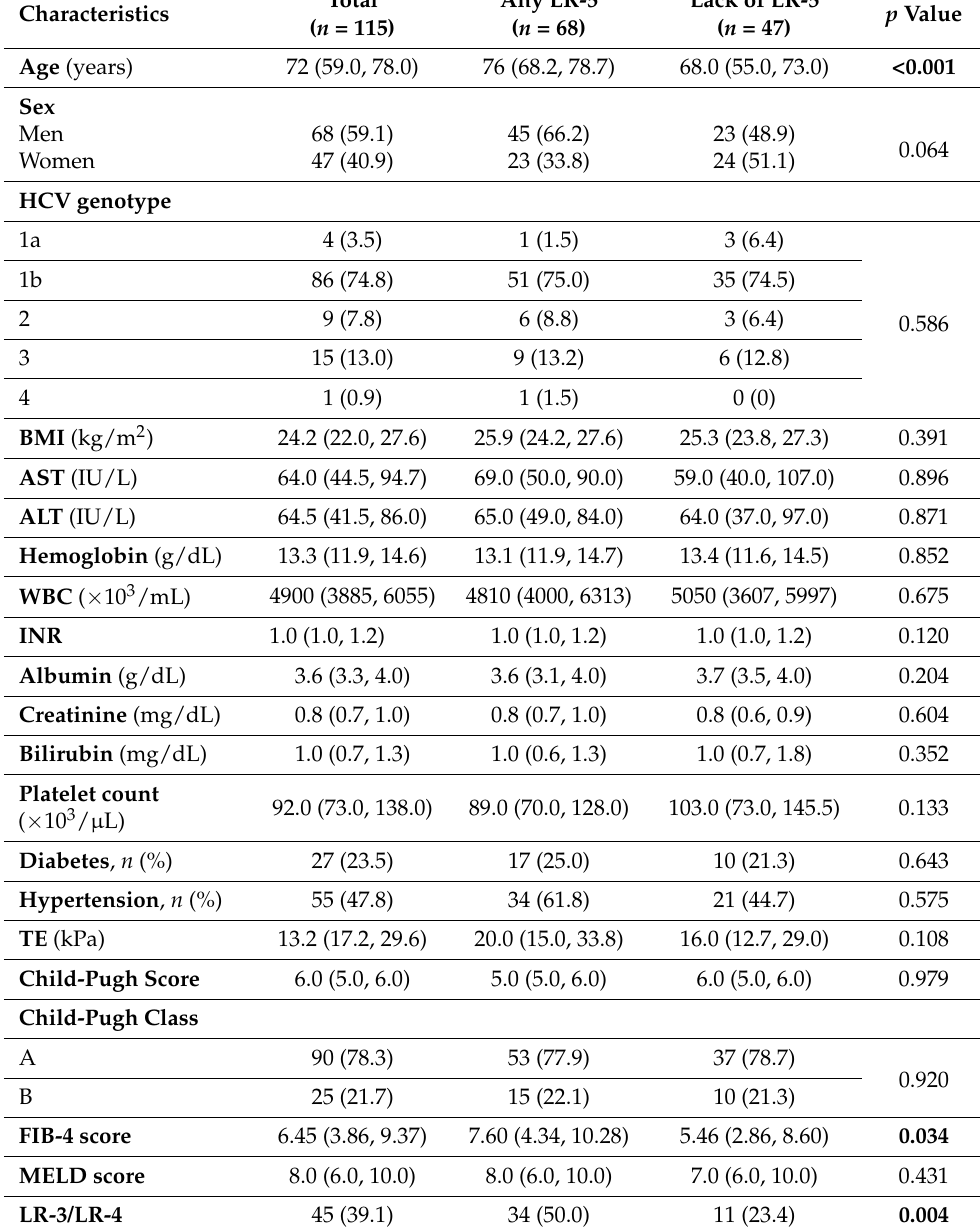
Table 1. Characteristics of the final population of patients with any LR-5 diagnosed before or after direct antiviral therapy and in patients without any LR-5 before or after direct antiviral therapy.